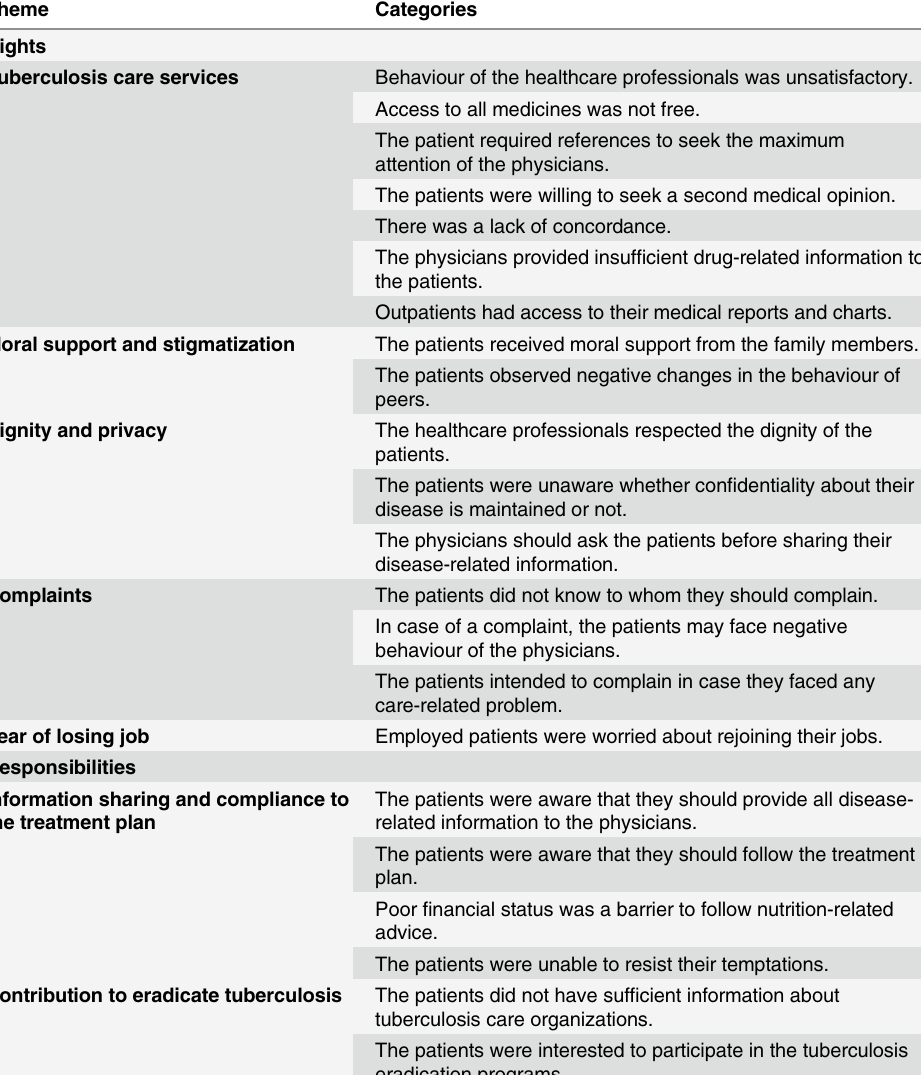
Table 2. Themes and categories of patients ’ rights and